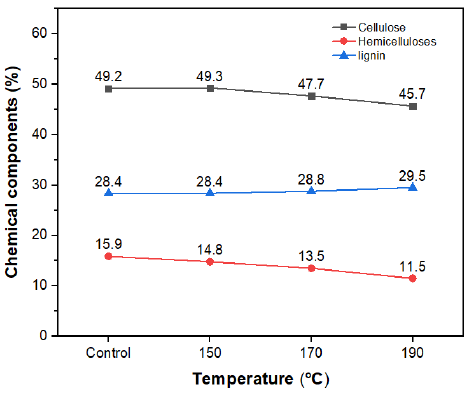
Figure 3. Main chemical components of Masson pine wood as a function of temperature.